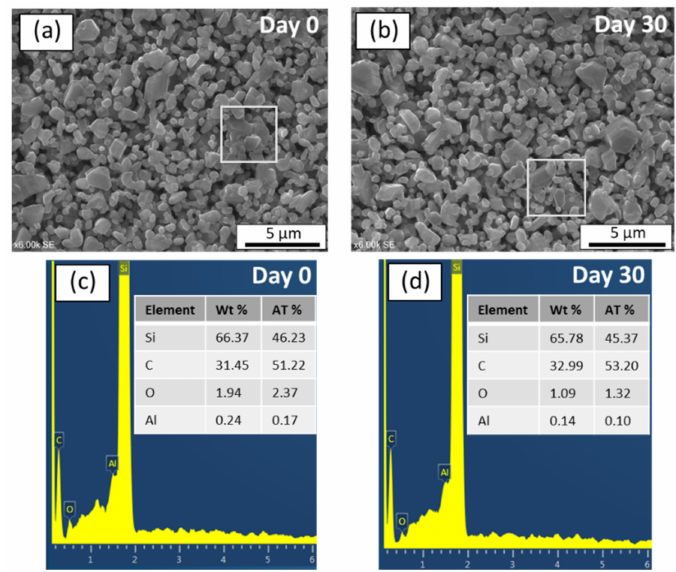
Figure 9. ( a , b ) SEM images of SiC membrane before and after acid corrosion, respectively and ( c , d ) Chemical composition of SiC membrane layer before and after acid corrosion, respectively.